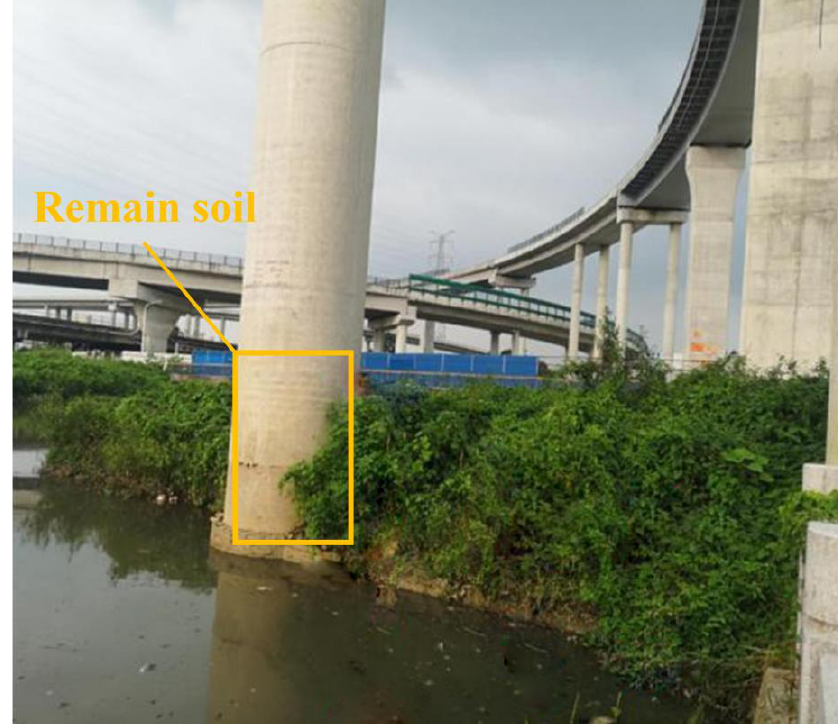
Figure 10. Surrounding conditions of Pier P30.